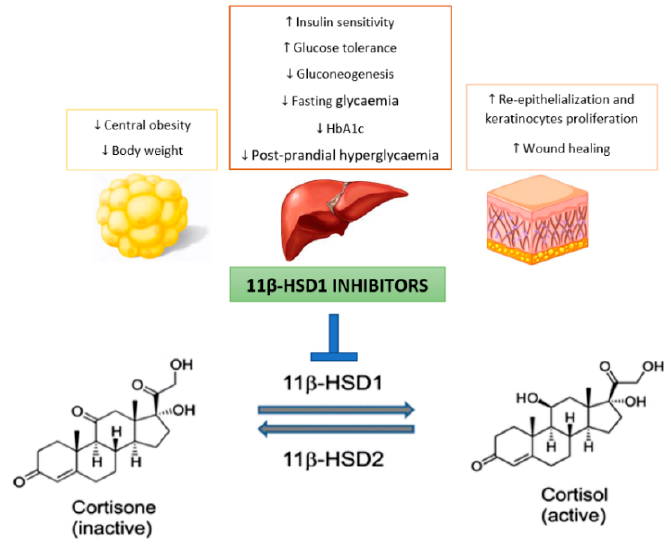
Figure 1. Potential benefits of selectively targeting 11 β -hydroxysteroid dehydrogenase type 1 (11 β -HSD1) for the treatment of type 2 diabetes mellitus (T2DM).